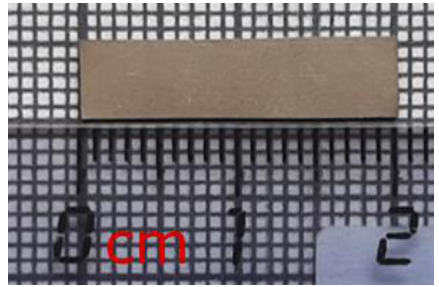
Table 1. Structure and geometric dimensions of the samples under study .